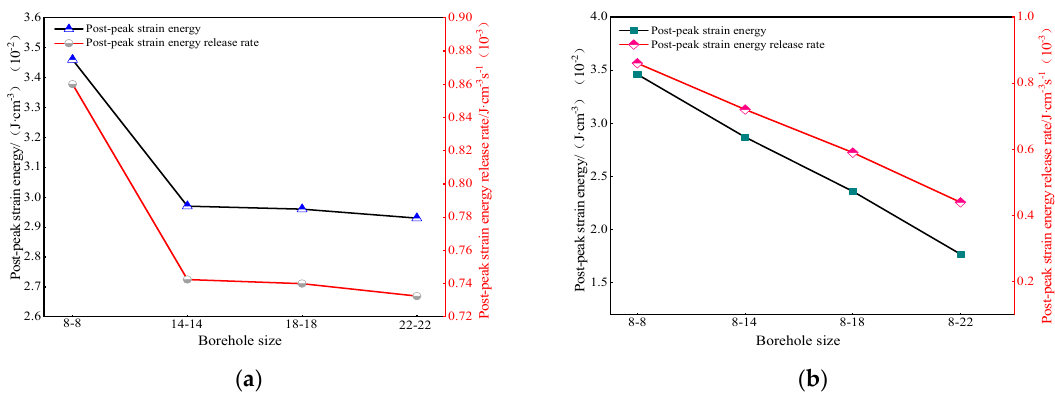
Figure 10. Post − peak strain energy and release rate of each drilled sample: ( a ) is post − peak strain Figure 10. Post-peak strain energy and release rate of each drilled sample: ( a ) is post-peak strain energy and release rate of samples drilled in the same diameter; ( b ) is post − peak strain energy and energy and release rate of samples drilled in the same diameter; ( b ) is post-peak strain energy and release rate of variable − diameter borehole samples. release rate of variable-diameter borehole